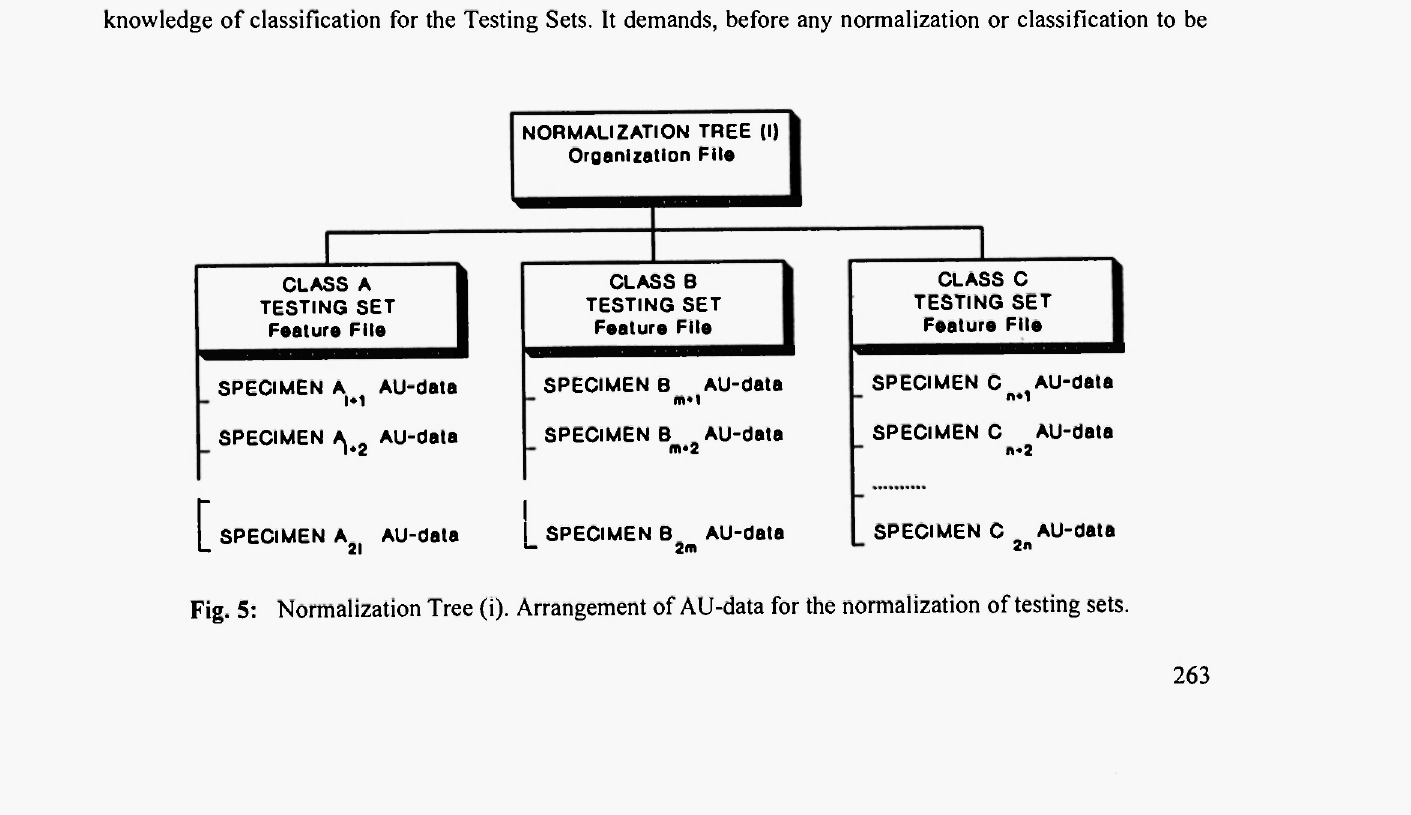
Fig. 5: Normalization Tree (i). Arrangement of AU-data for the normalization of testing